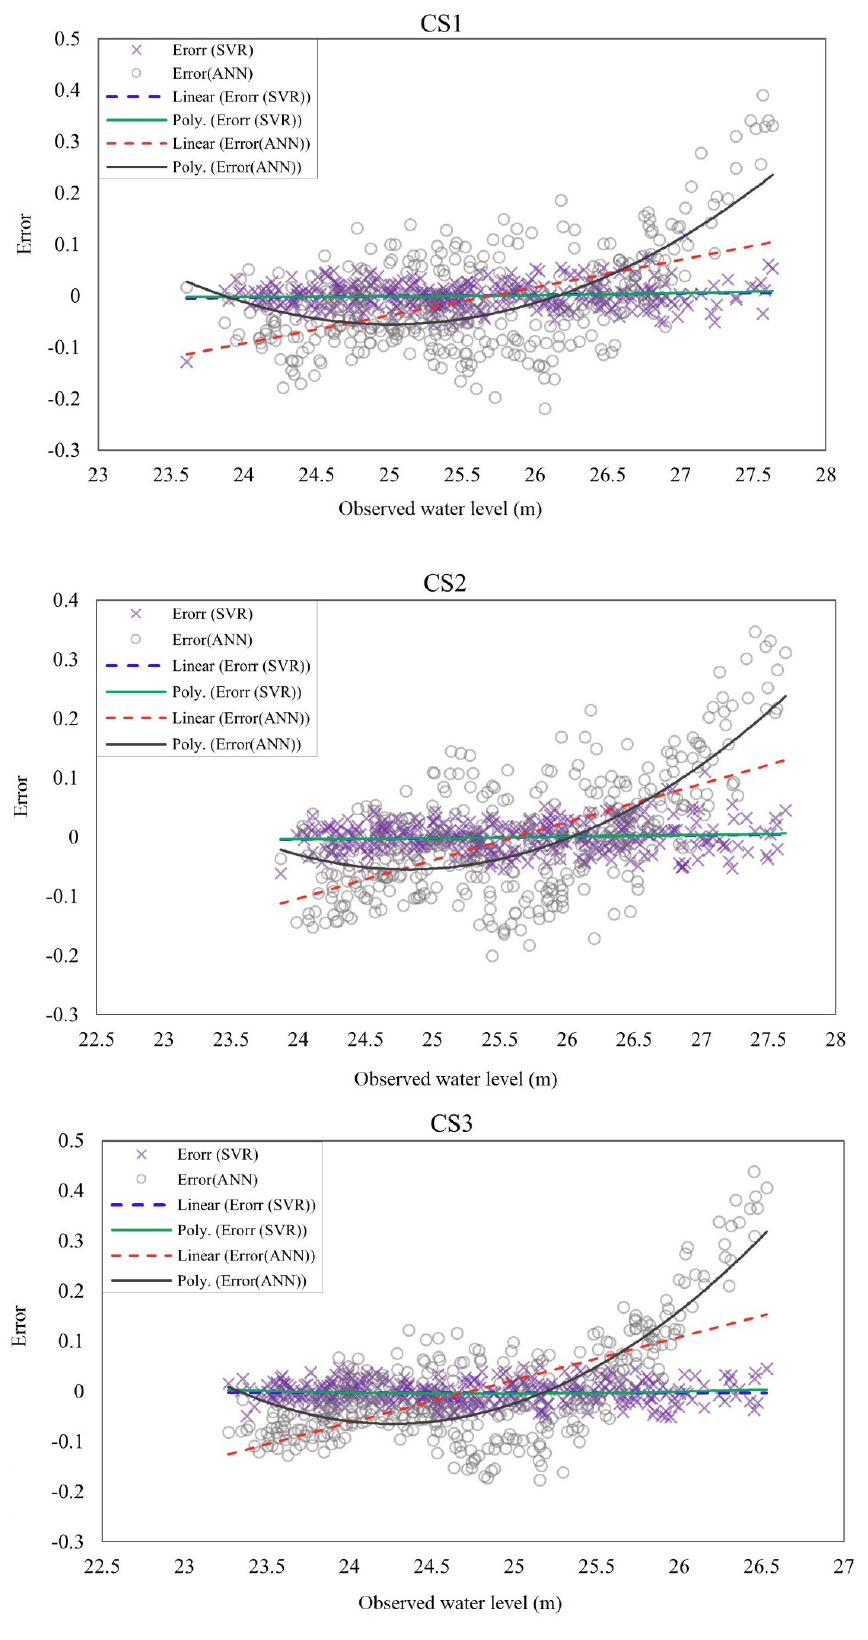
Figure 8. Error trend and linear and polynomial regression of error values resulted from SVR and ANN predicted water level at the specified cross sections ( CS1 to CS3 ).